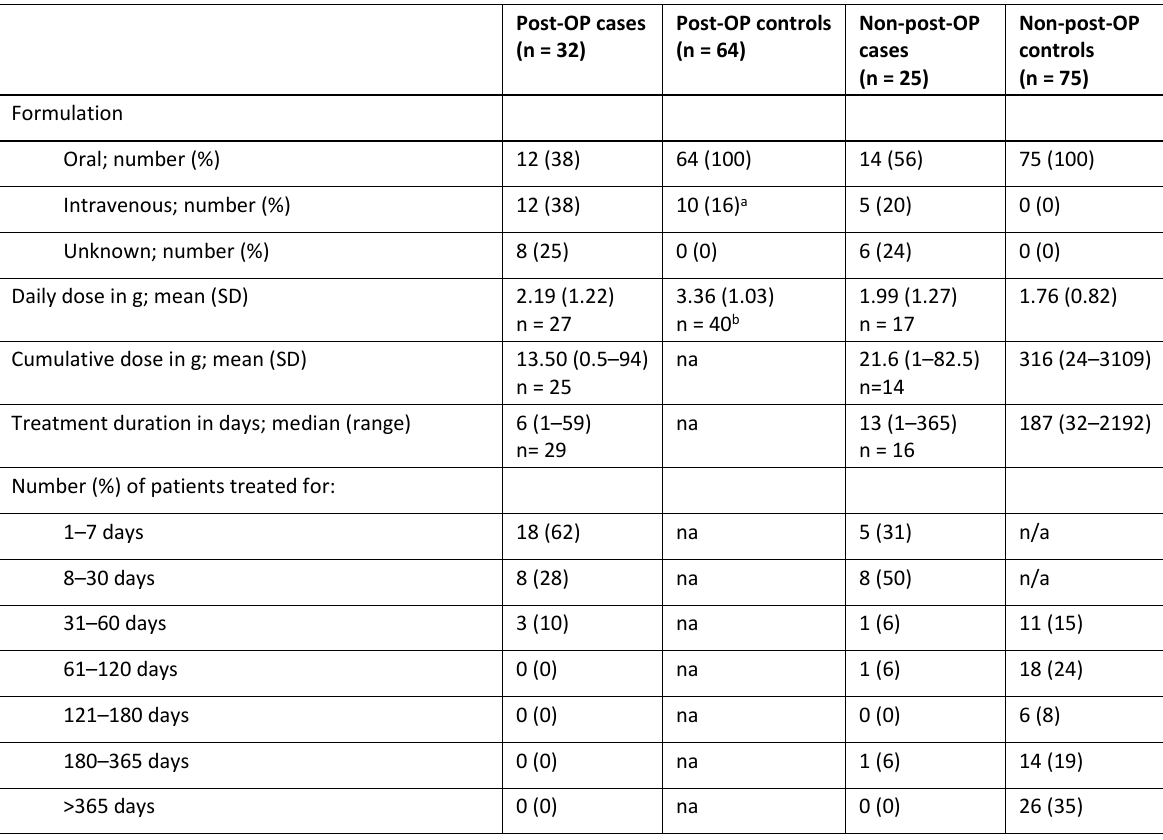
Table 2: Characteristics of metamizole